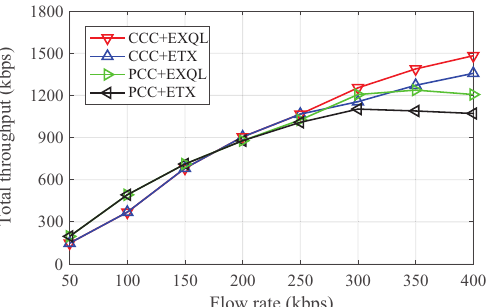
Figure 11. Total throughput versus flow rate in the grid network. EXQL, expected transmission count based on queue length.